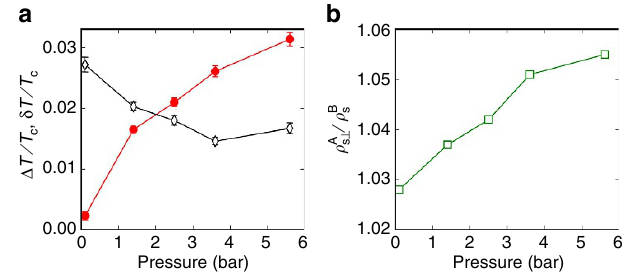
Figure 4 | Pressure dependence of the measured properties of the A–B transition. ( a ) The width of the B–A transition, D T / T c , (due to the pressure- induced bowing of the cavity) observed on warming (filled red circles) is compared to the extent of supercooling, d T / T c , (open black diamonds), which shows a non-monotonic behaviour. Lines are guides to the eye. Error bars represent s.e.m. (see Table 1 for details). ( b ) The ratio r s > A / r s B of superfluid fractions in the A and B phases near the transition; the departure from unity indicates the presence of the strong coupling effects down to low pressure.